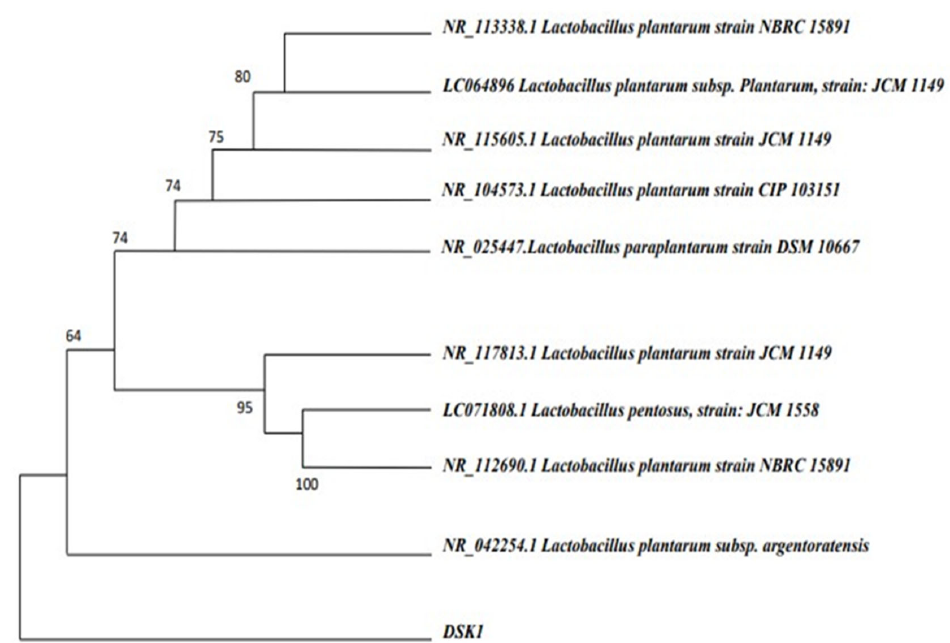
Figure 2. Phylogenetic tree of L. pentosus 124-2.